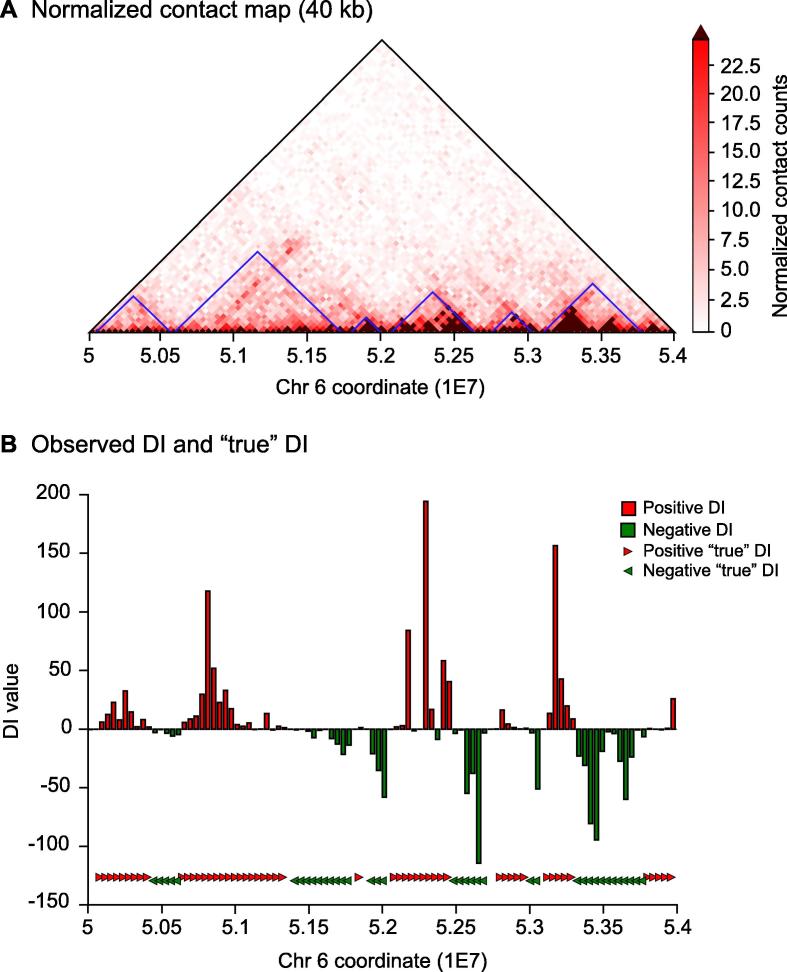
TADs for chromosome 6: [50–54] Mb at the 40-kb resolutionA. Triangular part of the normalized contact matrix. TADs calculated with GITAR are plotted in blue along the diagonal. B. Observed DI values and “true” DI values (HMM-biased states). Positive “true” DI and negative “true” DI refer to downstream and upstream HMM-biased states, respectively. HMM-biased states are plotted to show the correspondence with TAD boundaries (Y axis is not informative in this case). According to the HMM state shifts, six TADs and seven TAD boundaries are present. DI, directionality index.